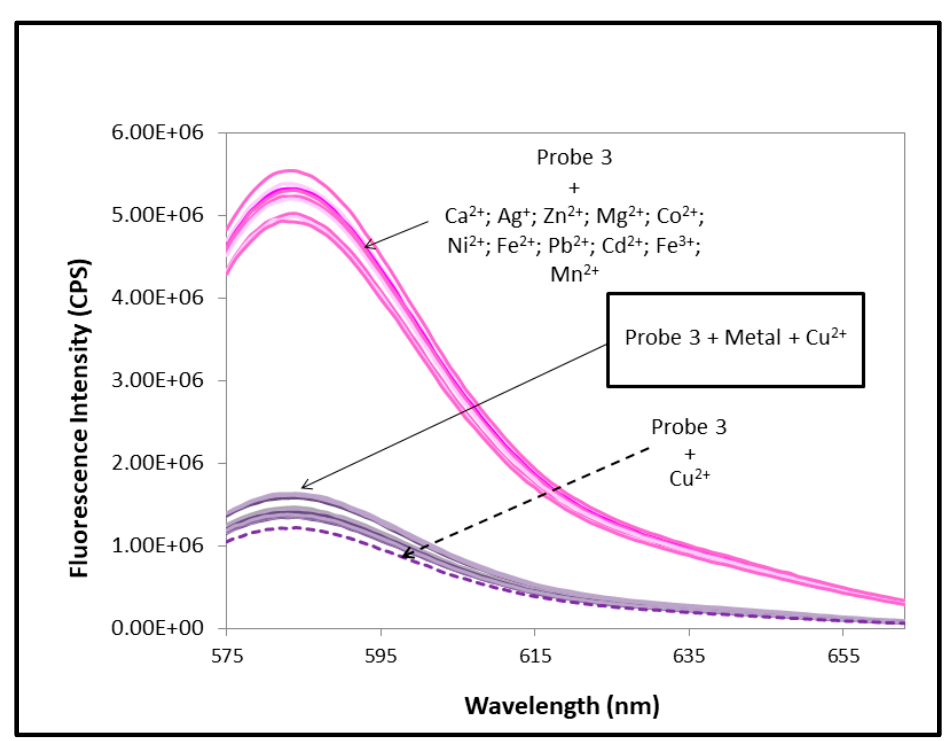
Figure 3. Metal-ion selectivity of Probe 3 (1 µ M) in acid conditions (pH 4.7). The pinkish lines represent the emission of the 11 solutions containing Probe 3 (1 µ M) and 1 equiv. of one of the following metal ions: Ca 2 + ; Ag + ; Zn 2 + ; Mg 2 + ; Co 2 + ; Ni 2 + ; Fe 2 + ; Pb 2 + ; Cd 2 + ; Fe 3 + ; and Mn 2 + . The magenta lines represent the fluorescence quenching of a solution of Probe 3 (1 µ M) and 1 equiv. of the cations